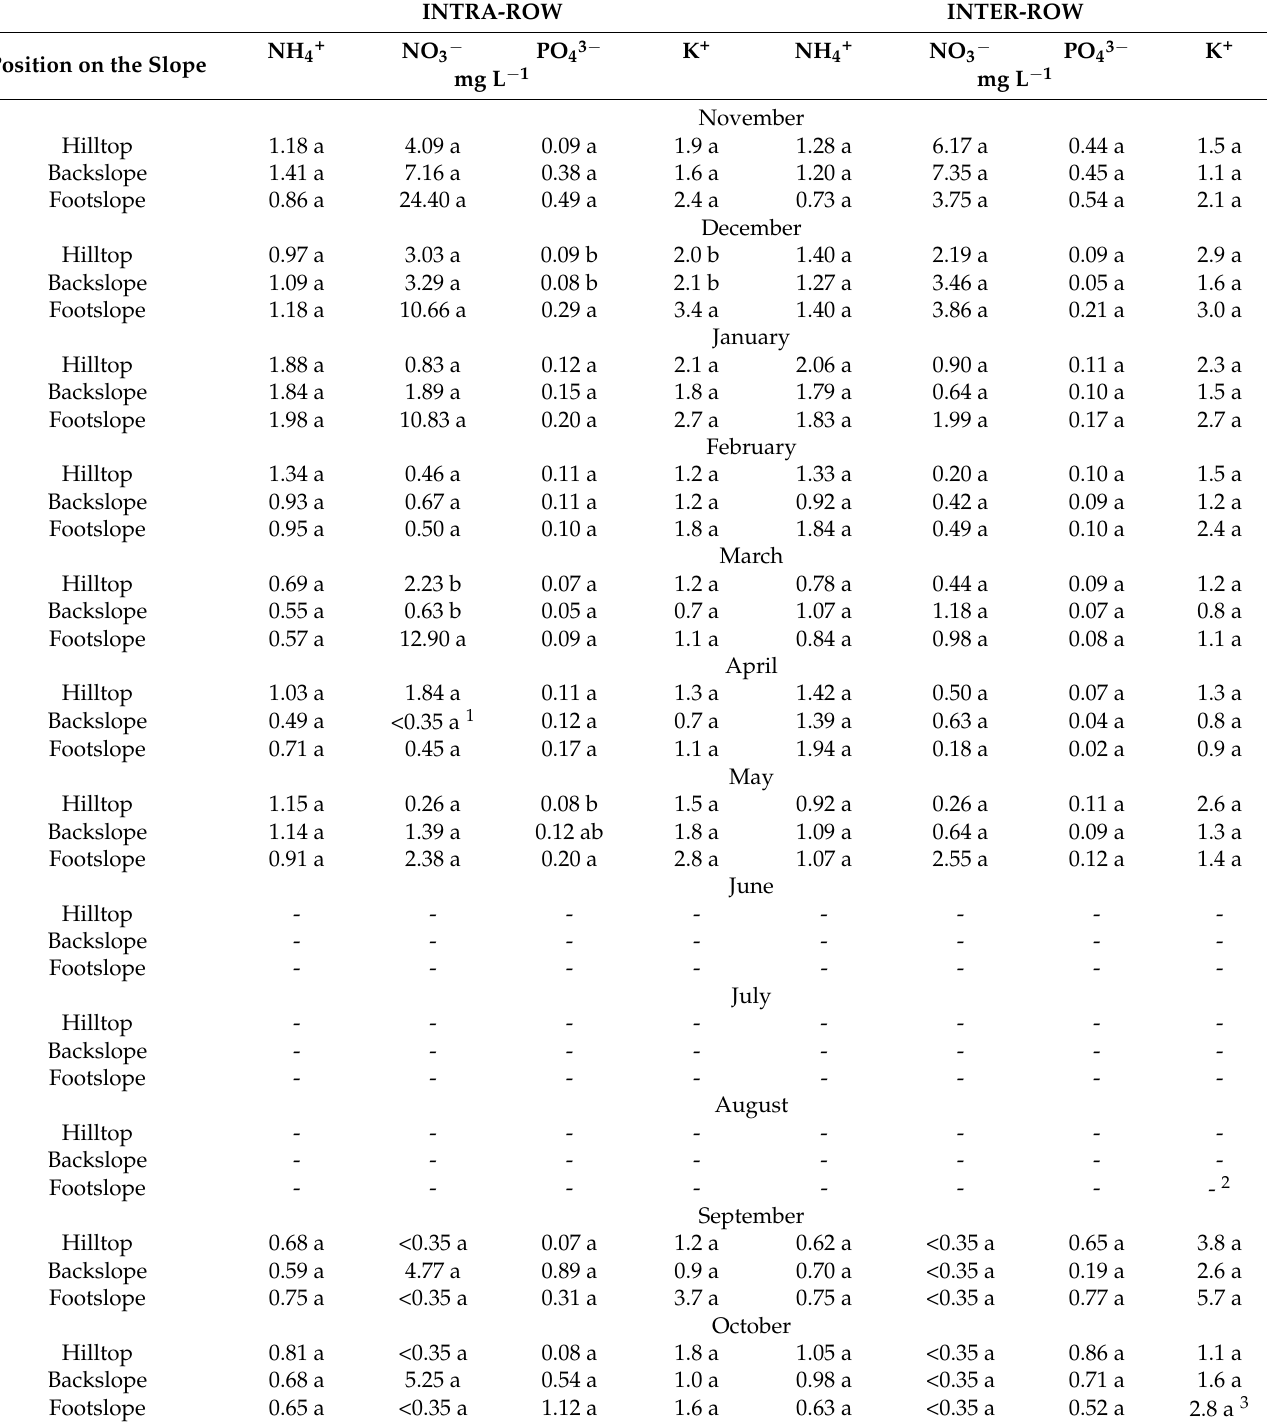
Table 3. Nutrient ions average concentrations each month in leachates collected for two years (2 November 2020–25 November 2022) from wick lysimeters installed at the hilltop, backslope and footslope of vineyard intra- and inter-row. In June, July, and August there was no water in wick lysimeters, and thus no leachate